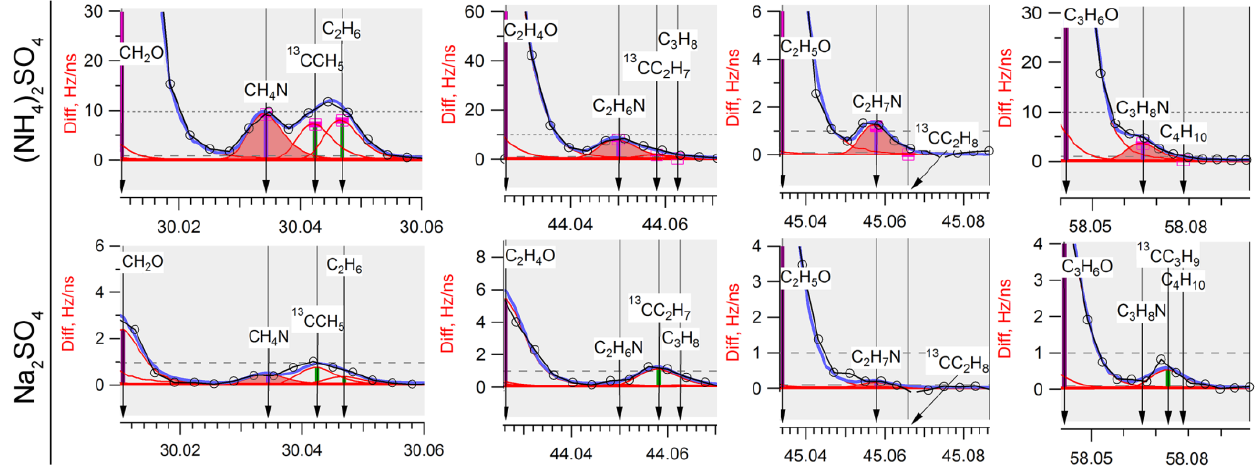
Fig. 6. ToF-AMS difference spectra (open minus closed chopper) showing organic nitrogen (amine) fragments from the reactive uptake of trans β -IEPOX onto AS vs. Na 2 SO 4 seeds. Similar fragments were observed for cis β -IEPOX using NH + Na + -based